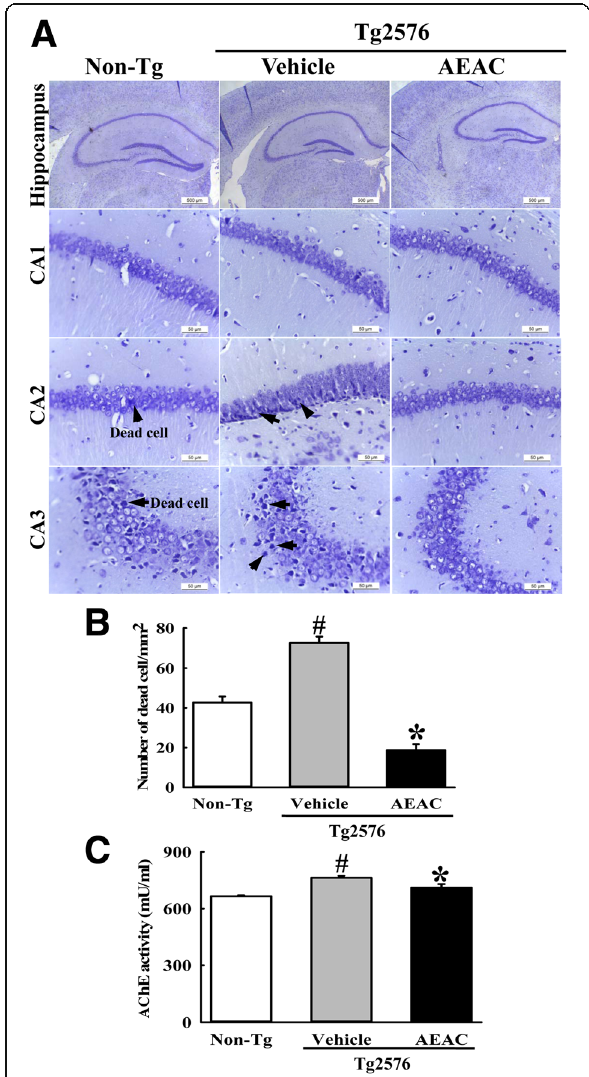
Fig. 8 Survival and function in the hippocampus of Tg mice. a After AEAC administration for 4 weeks, brain tissues were collected from subset groups and histological changes were determined as described in the Methods. The slide sections of brain tissue were stained with Nissl and then observed at 400× magnification. b The total number of neuronal cells was calculated per 80 mm 2 . c AChE activity was measured using the homogenate of hippocampus tissue collected from two mice after AEAC treatment. Data shown are means ± SD ( n = 5). # , P < 0.05 compared with the Non - Tg group. *, P < 0.05 compared with the Vehicle treated Tg2576